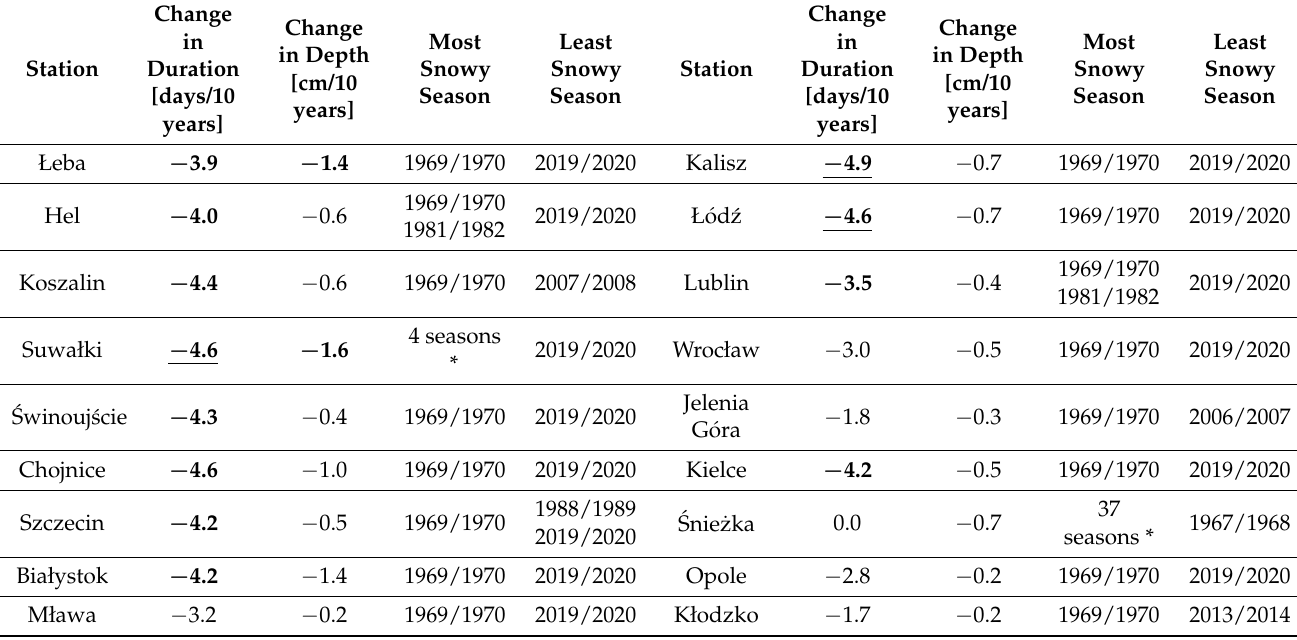
Figure 7. Course of the number of days with snow cover ( blue ) and mean thickness of snow cover ( red ) in winter in the years 1966/67–2019/20 with rate of changes. Table 2. Variability of snow cover duration and mean depth for winter months in seasons 1966/67–2019/20. Stations are arranged in spatial order from the north to the